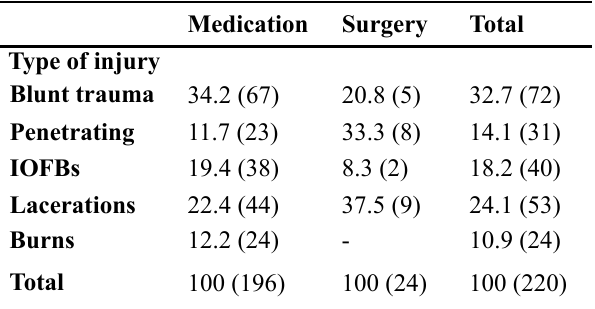
Table 1 . Types of injuries (in % and numbers ( n )) in relation to the treatment strategy at initial presentation to the hospital